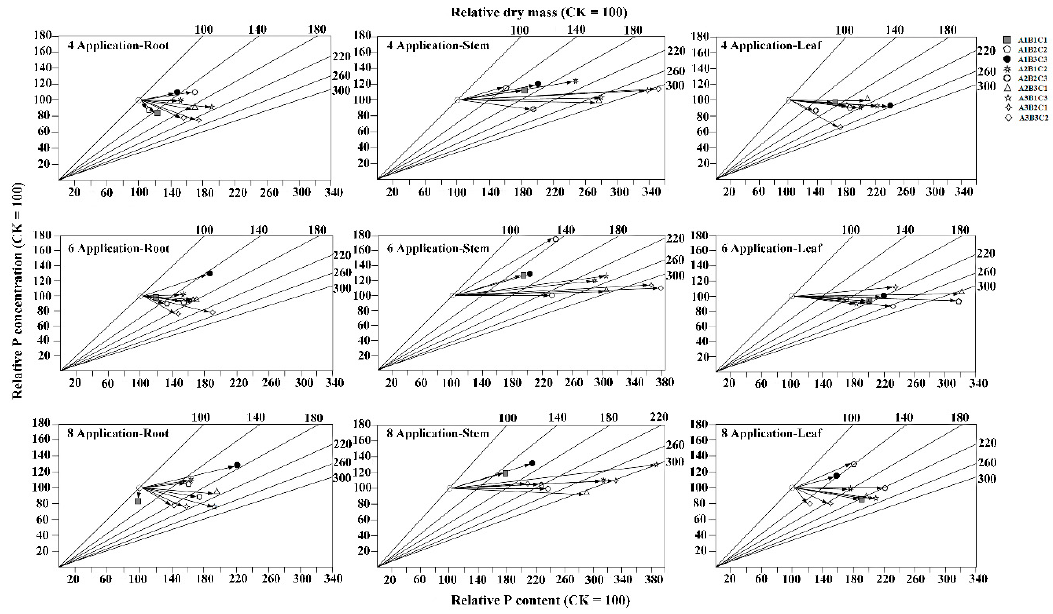
Figure 6. Vector diagram of relative changes in dry mass, P content, and P concentration at the end of the growing season after application of NPK fertilizer. Note that this vector diagram is based on the status of CK.